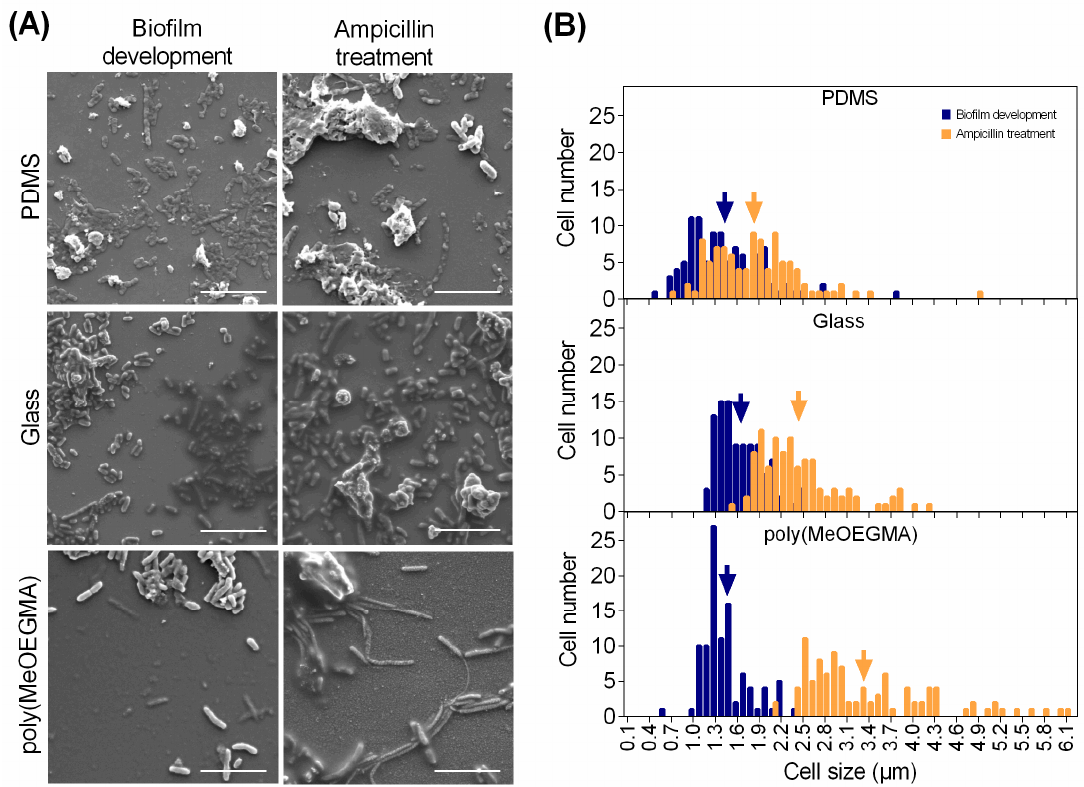
Figure 4. SEM analysis of biofilms formed after 24 h of development and after the ampicillin treatment on PDMS, glass and poly(MeOEGMA) brush: ( A ) representative micrographs (magnification: 5000 × ; bars = 10 µ m); ( B ) cell size distribution of biofilms before ( (cid:4) ) and after ampicillin exposure ( (cid:4) ). The arrows represent the average cell length determined from SEM micrographs for each experimental condition.